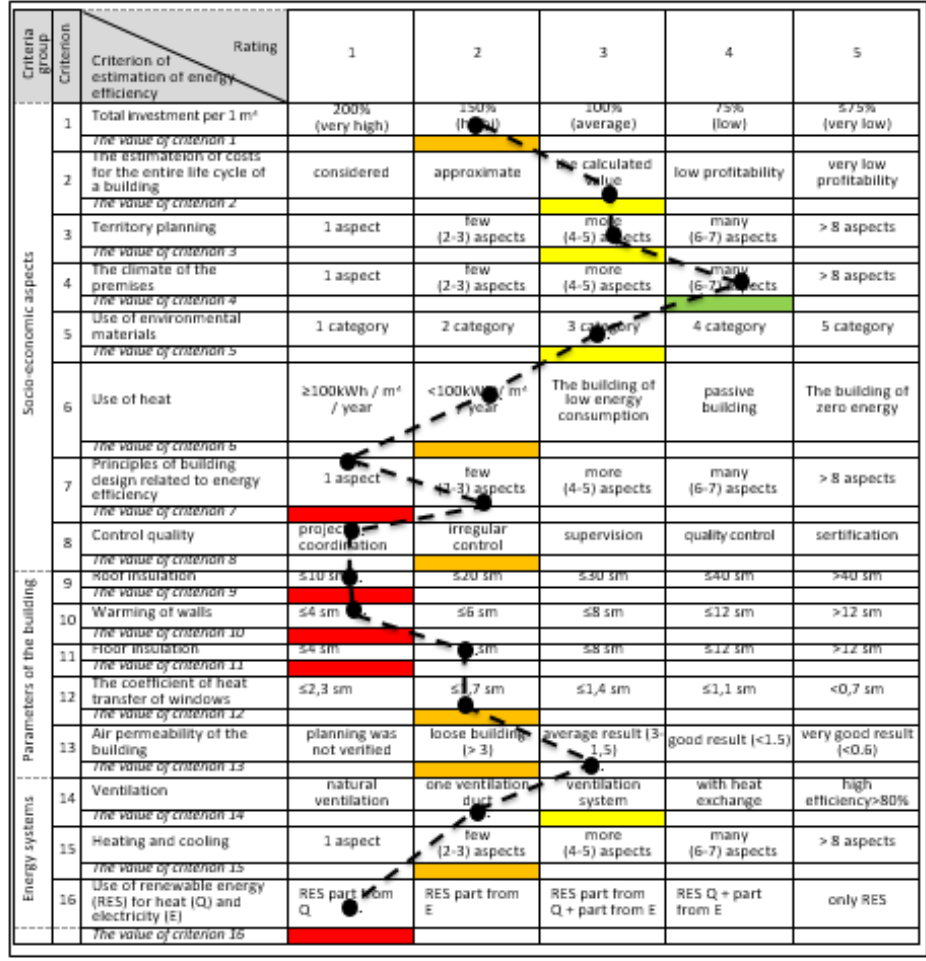
Fig. 6: Energy profile for KNUTD buildings based on DGNB energy audit (Fragment: assessment of educational building 4)